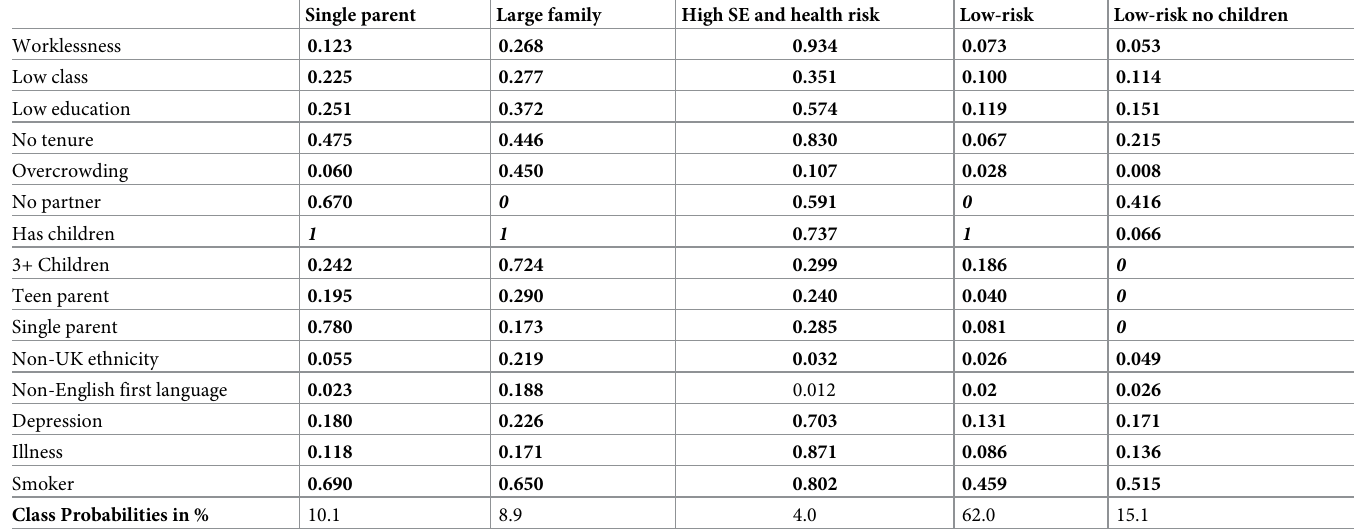
Table 5. Conditional response probabilities by latent class for